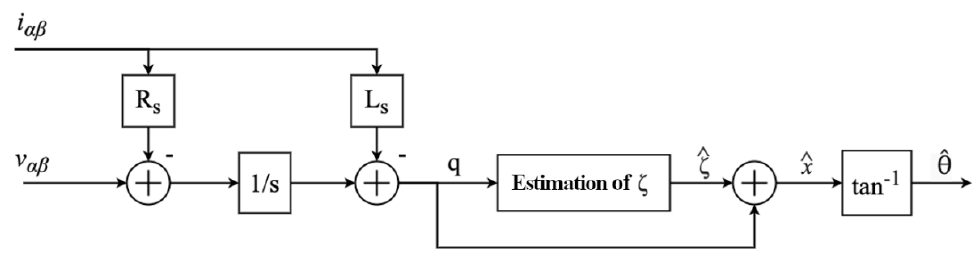
Figure 9. Bobtsov’s position observer.